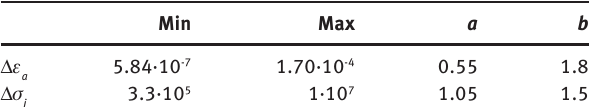
Table 1: Fitting parameters for the probability distributions in Figure 4. Min Max